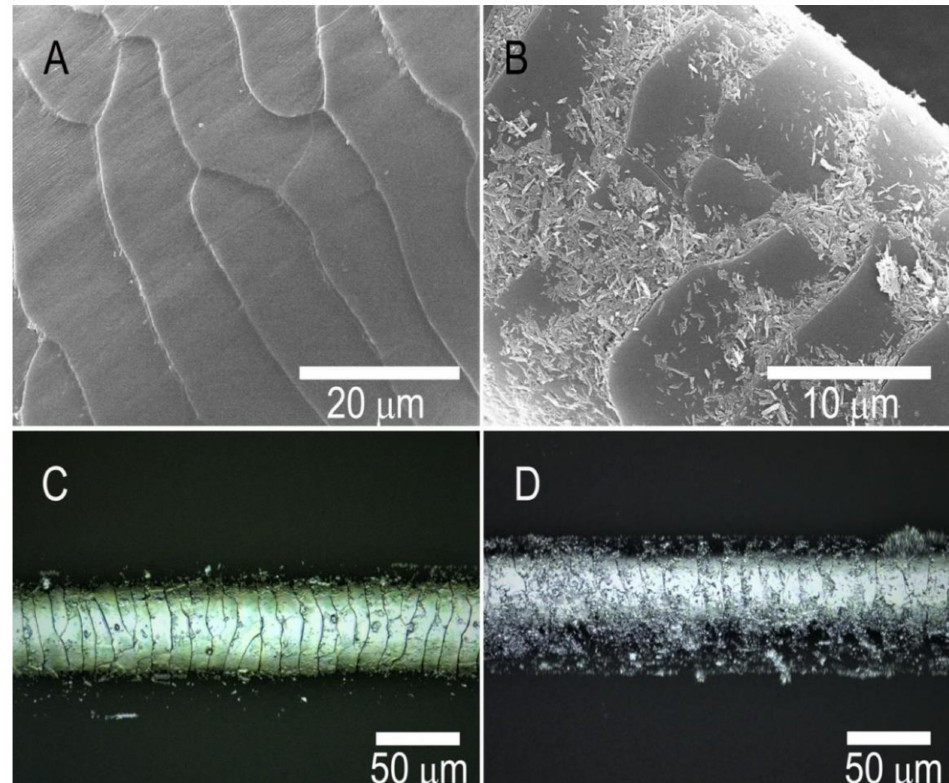
Figure 3. Self-assembly of the clay nanotubes on guinea pig hair surface: SEM and 3D confocal optical microscopy images of the pristine hair ( A , C ), and hair surface coated with halloysites where nanotubes are mostly accumulated near the cuticle openings ( B , D